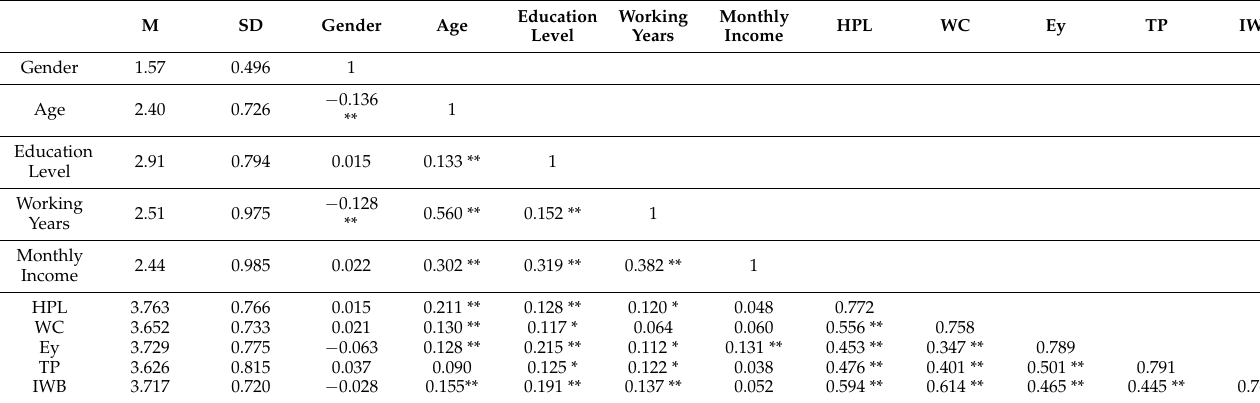
Table 3. Summary of Correlation Analysis.